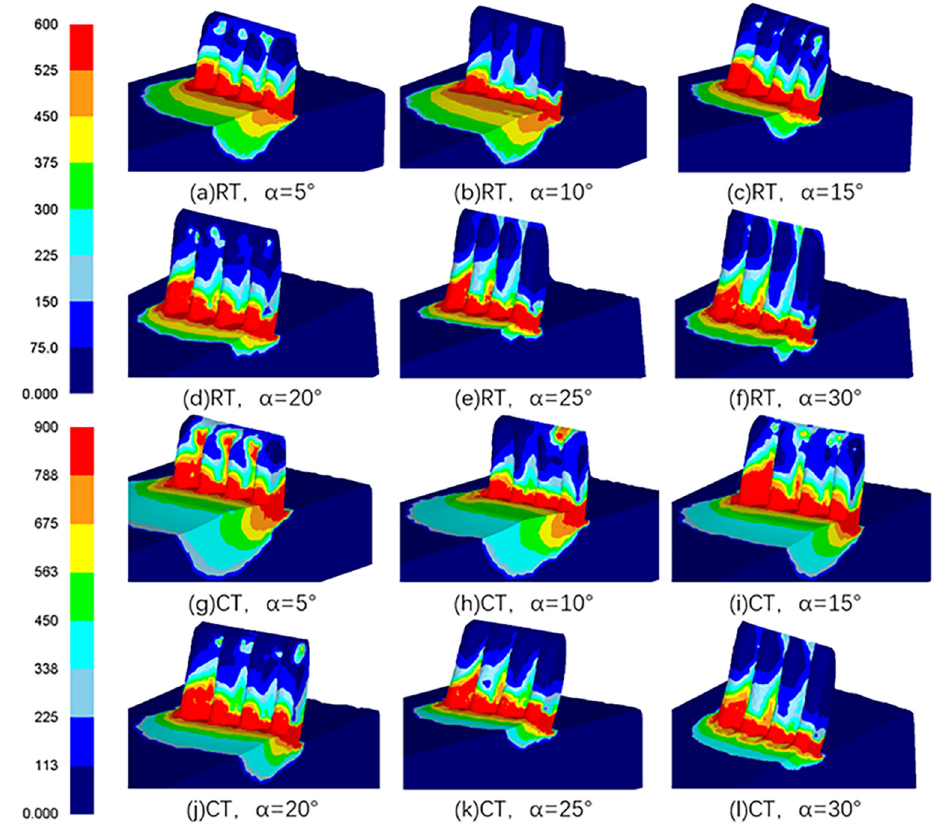
Figure 10. Effective stress distribution of the fins under different conditions.